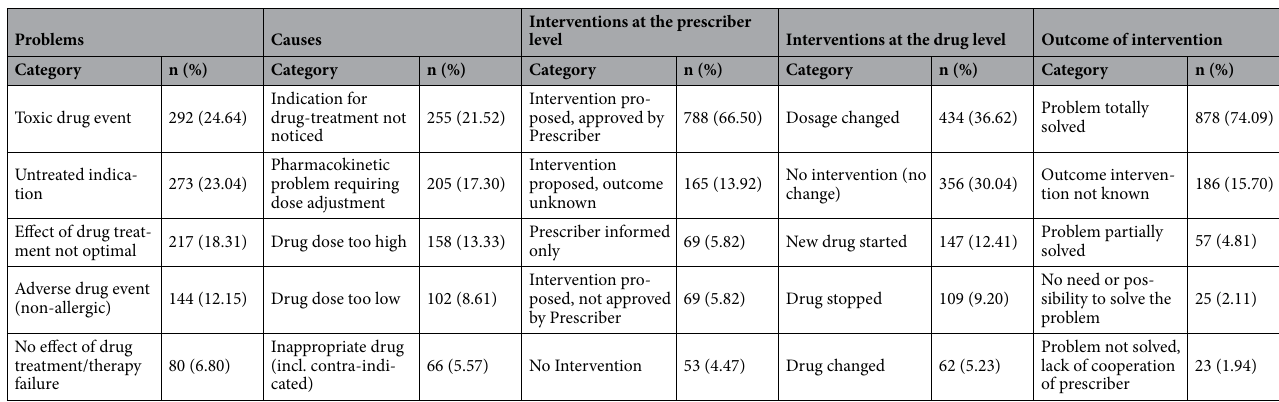
Table 2. Description of the drug related problems, associated pharmaceutical interventions and outcomes. Only the five categories most frequently found are listed. Total number of DRP: 1185.